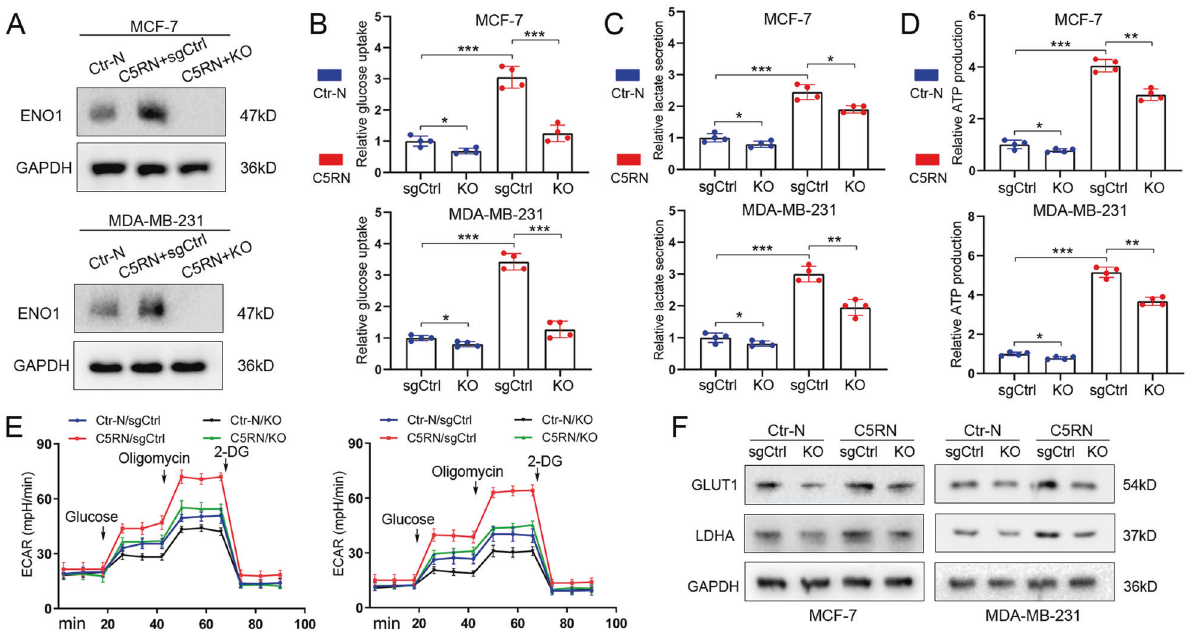
Fig. 3 ENO1 KO reverses the C5RN-induced glycolysis of breast cancer cells. A Immunoblotting analysis of ENO1 in MCF-7 and MDA-MB- 231 cells treated with C5aR1-negative neutrophils (Ctr-N) and C5aR1 + neutrophils (C5RN) with or without ENO1 knockout (KO). B ENO1 KO signi fi cantly alleviated the enhanced glucose uptake effect of C5RN on BC cells. C ENO1 KO signi fi cantly alleviated the enhanced lactate production effect of C5RN on BC cells. D ENO1 KO signi fi cantly alleviated the enhanced ATP production effect of C5RN on BC cells. E ENO1 KO signi fi cantly alleviated the enhanced ECAR effect of C5RN on BC cells. F Immunoblotting analysis of GLUT1 and LDHA in MCF-7 and MDA-MB- 231 cells treated with C5RN with or without ENO1 KO. Data represent the mean ± SD of at least three independent experiments. * P < 0.05, ** P < 0.01, *** P <